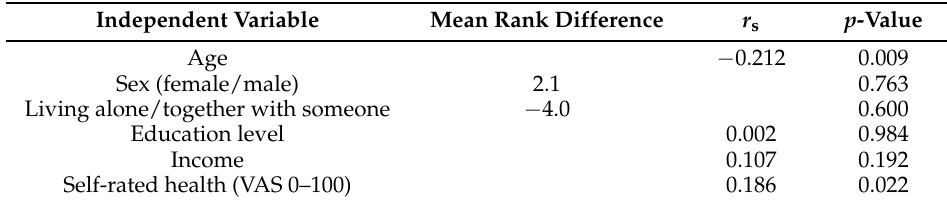
Table 3. Associations between PIADS total score for eHealth service illustrations in future and respondents’ profile variables ( n =